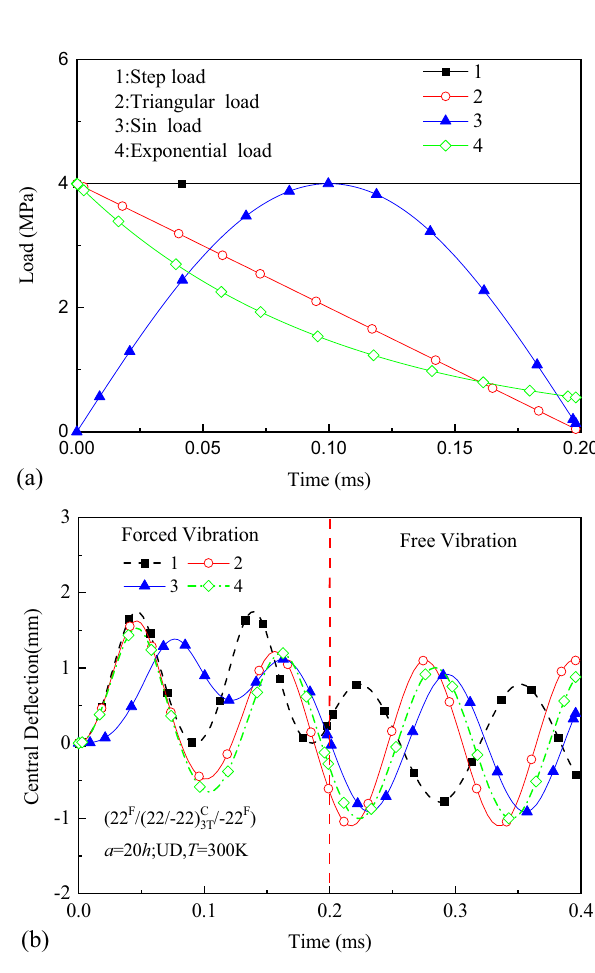
Figure 11: E ff ect of dynamic load on forced vibration of hybrid plates. ( a ) Type of dynamic loads. ( b ) Vibration